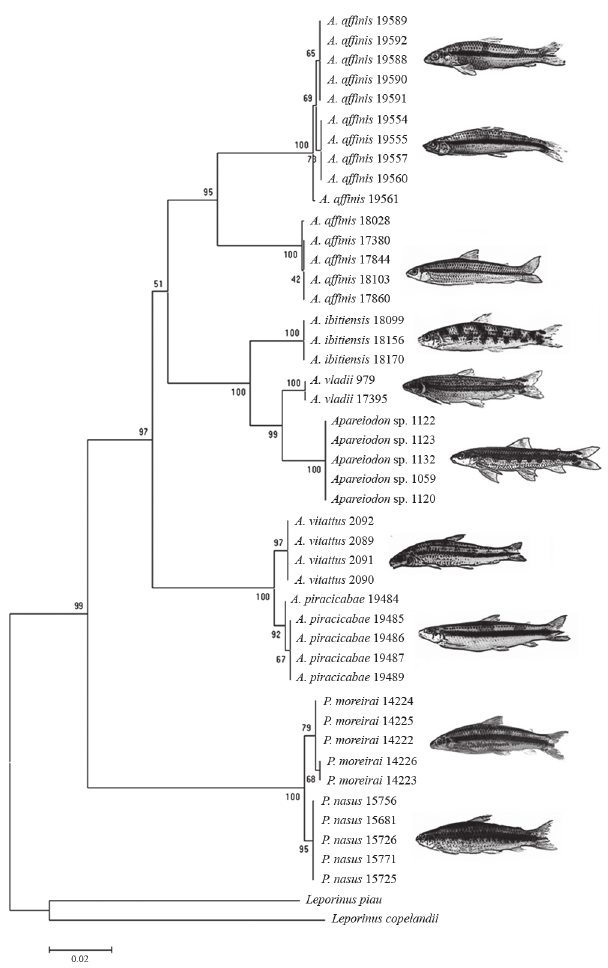
Fig. 2. K2P distance NJ dendrogram showing the nine analyzed species/populations of Parodontidae from the La Plata River